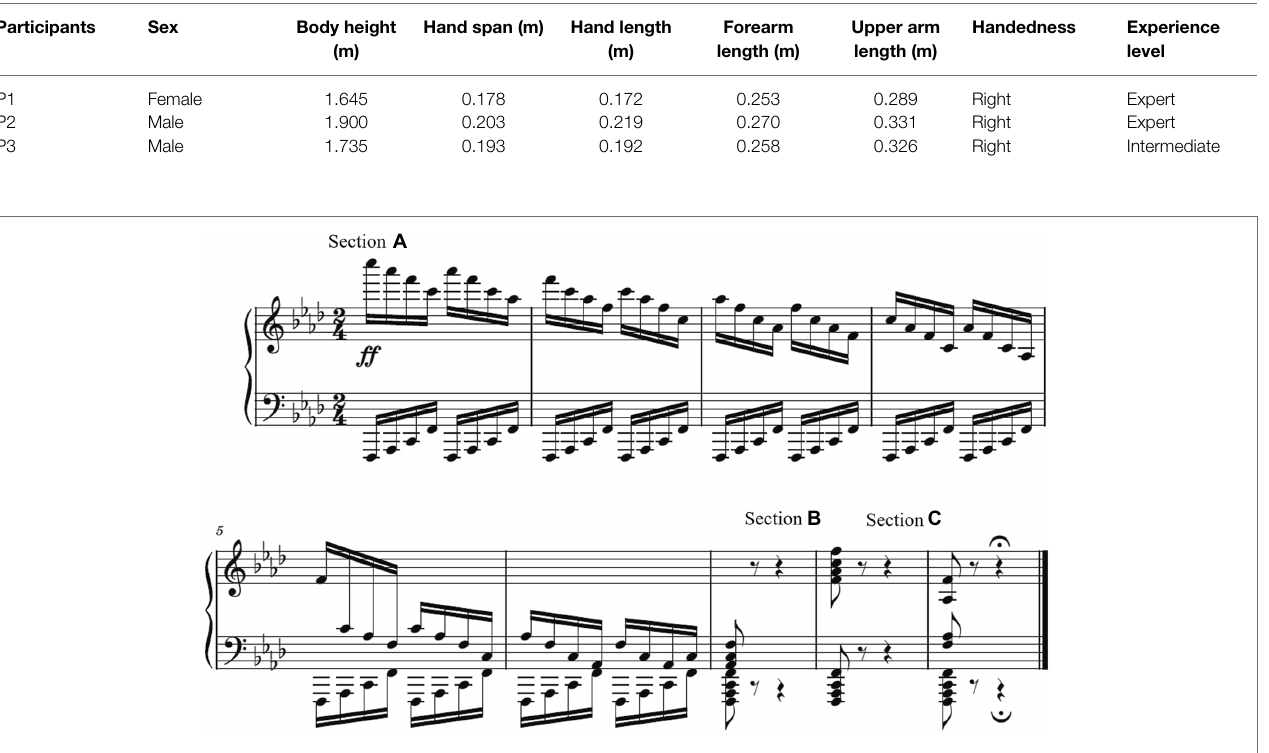
TABLE 1 | Sex, select anthropometric measures, handedness, and experience level of each participant in the study. Participants